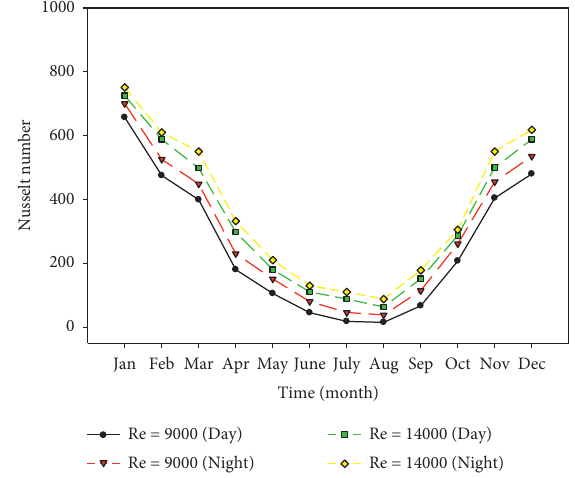
Figure 12: Effect of aspect ratio on Nusselt number for reactor inclined at 1 ° , Re � 9000, and water depth � 5.6mm.